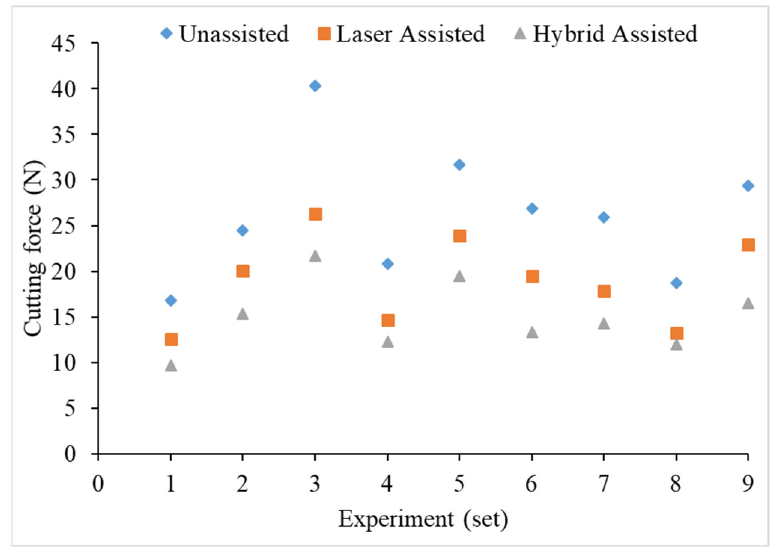
Figure 7. Comparison chart of the cutting force of various process parameters of the Taguchi method for unassisted, laser-assisted, and hybrid-assisted systems.